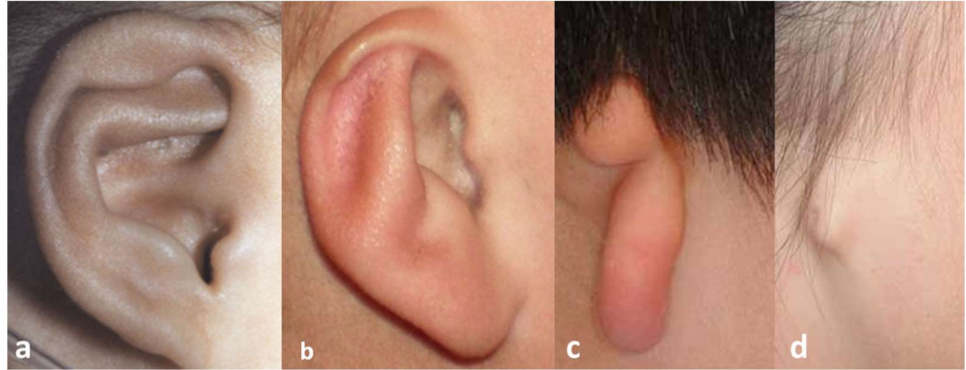
Figure 1. Grade of microtia: ( a ) grade I, ( b ) grade II, ( c ) grade III, ( d ) grade